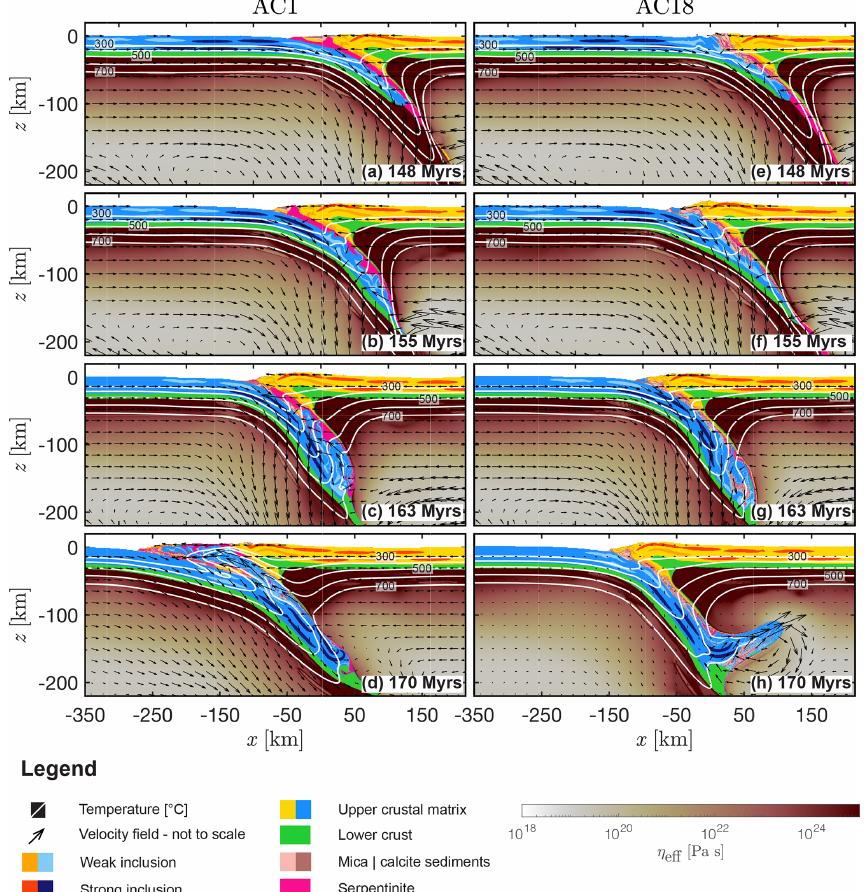
Figure 8. Convergence and collisional stage of AC1 and AC18 (low and high shear resistance of serpentinite, complex density model, feldspar-dominated upper crust). White to dark red indicates the effective viscosity of the mantle material calculated by the algorithm, yellow to orange indicates the crustal matrix and the weak and strong inclusions of the overriding plate, light to dark blue indicates the corresponding crustal units of the subducting plate. The material parameters used for the upper crustal phases of the overriding and the subducting plates are identical. Green indicates the lower crust of both plates and salmon and brown indicates the sedimentary units. White lines are different isotherms and the arrows indicate the velocity field calculated by the numerical